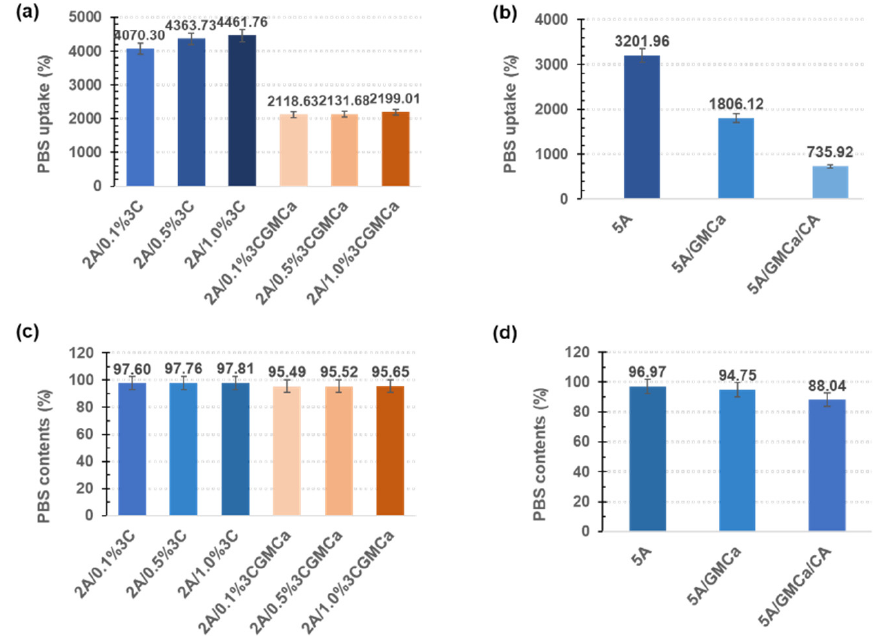
Figure 6. Photographs of the beads in different states: (top) swelling state, (middle) oven-dried state, and (bottom) freeze-dried state; ( a ) alginate-chitosan (2A/x%3C, x = 0.1, 0.5, 1.0) and GM-loaded alginate-chitosan (2A/x%3CGMCa, x = 0.1, 0.5, 1.0) beads, and ( b ) alginate (5A), GM-loaded alginate (5A/GMCa), and GM-loaded alginate crosslinked with citric acid (5A/GMCa/CA) beads.